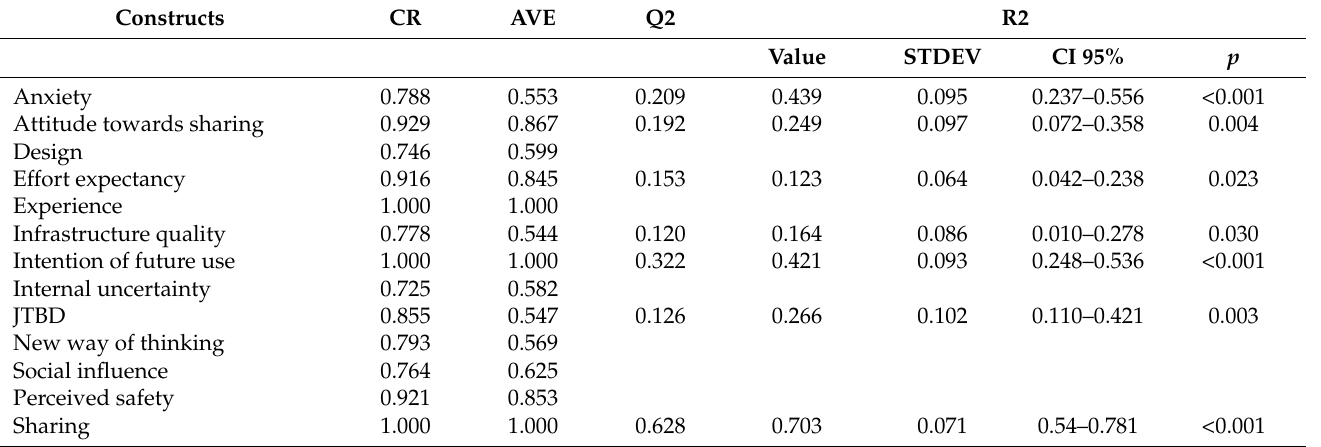
Table 3. Measurement values: composite reliability (CR), average variance extracted (AVE), predictive relevance with omission distance (Q2), standard deviation (STDEV), and coefficient of determination (R 2 ) with confidence interval and p value ( p